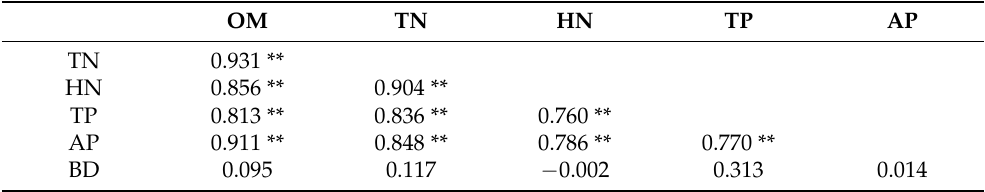
Table 12. Pearson correlation between all the nutritive elements. OM